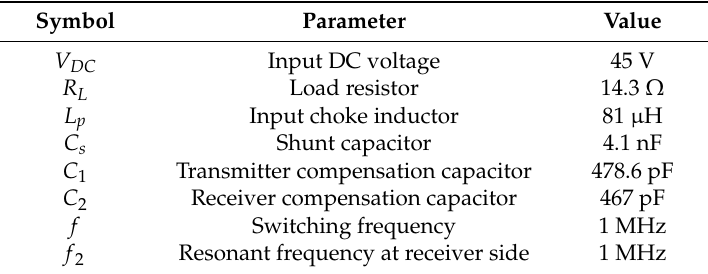
Table 2. Parameters of the WPT system with Class-E